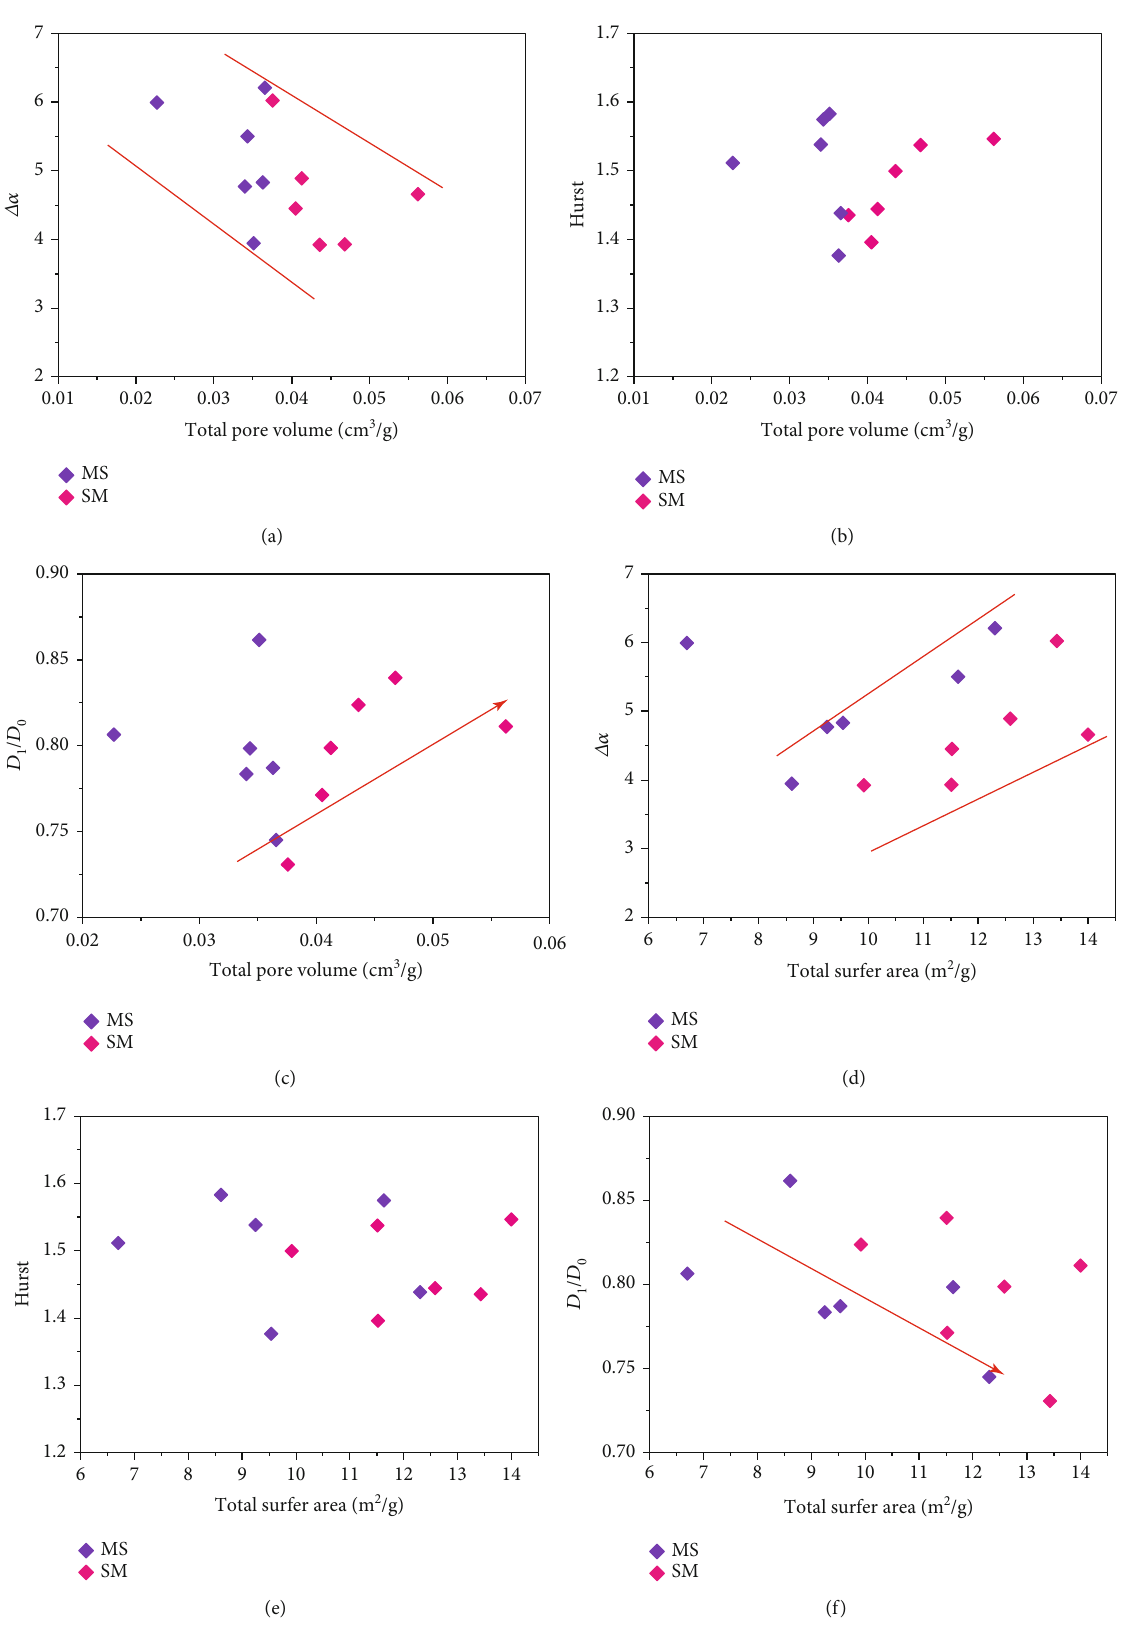
Figure 11: Relationships between total pore volume and Δα (a), total pore volume and Hurst (b), D surface area and Δα (d), total surfer area and Hurst (e), and total surfer area and D